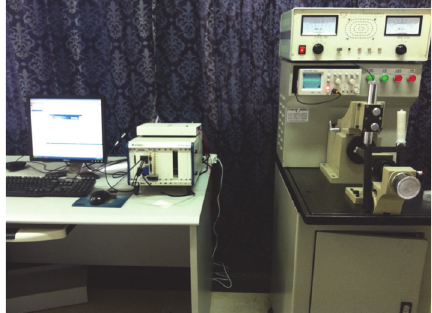
Figure 2: Experimental device.